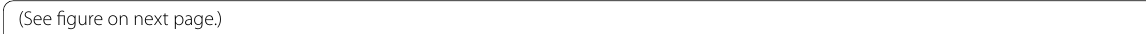
figure on next Fig. 1 Results of Experiment 1. a Change in body temperature during the challenge period based on body temperature at 0 d.p.i.. b Percentage of pigs positive for virus shedding in nasal swabs collected at -2, 1, 3, and 5 d.p.v. and 0 to 5 d.p.i. c Viral titers in nasal swabs collected after vaccination and challenge. d Viral titers in BALF collected at 5 d.p.i.. ( e , f ) Geometric mean of serum HI antibody titers against H3N2 TX98 ( e ) and H3N2 CO99 ( f ) collected at -2, 7, 14, and 20 d.p.v. and 0 and 5 d.p.i.. ( g ) Percentage of each lung lobe presenting macroscopic lesions. Differences between treatment groups were determined by Tukey’s ( a , g ) or Dunn’s ( c - f ) multiple comparisons tests. Survival curves were compared using the Mantel-Cox log-rank test ( b ). A statistically significant difference between two groups is indicated by a star ( a ) or different letters ( b - g ). Data are represented as mean SEM ( a - d , g ) or geometric mean ( e , f ). Symbols represent treatment groups ( a , b ) or individual pigs ( c - g ±